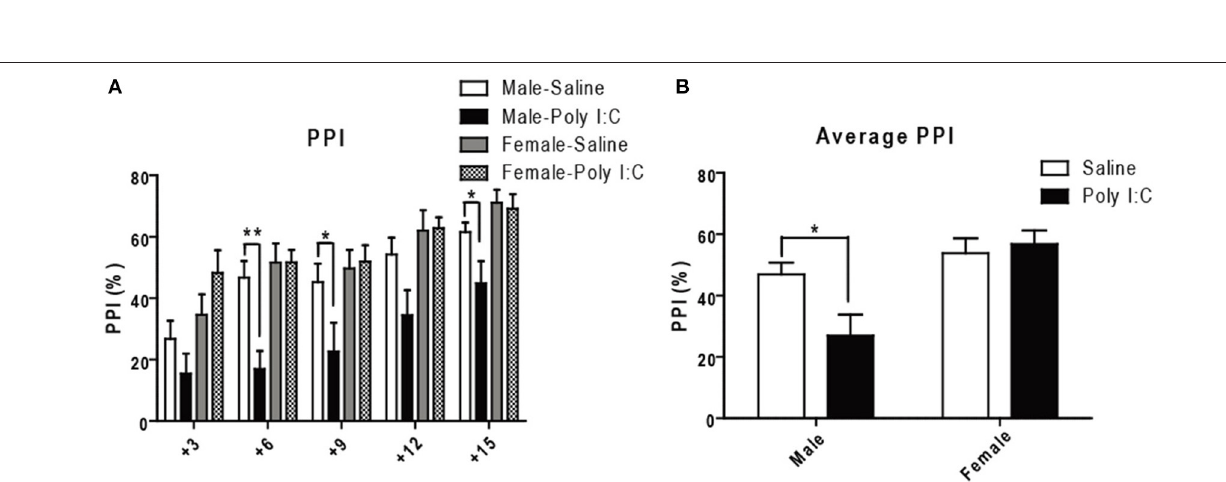
Frontiers in Molecular Neuroscience |